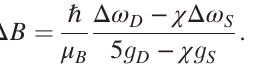
FIG. 7. Frequency shift of the S 1 Zeeman effect along the trap axis. Within the error bars of about 2 π × 0 . 2 Hz, the ac Zeeman shift is similar for both S sensor states.